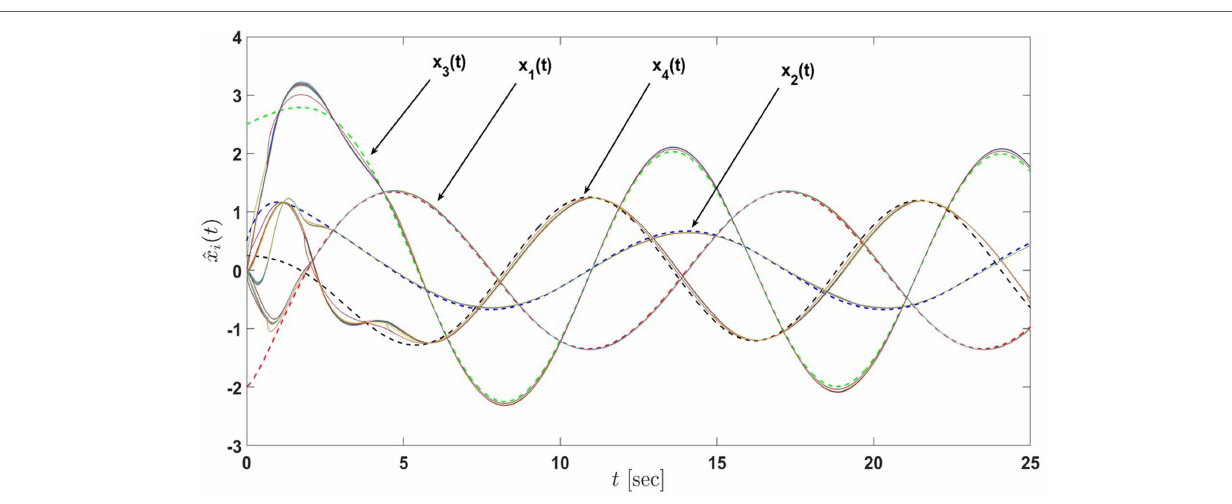
Fr ontiers in Robotics and AI |